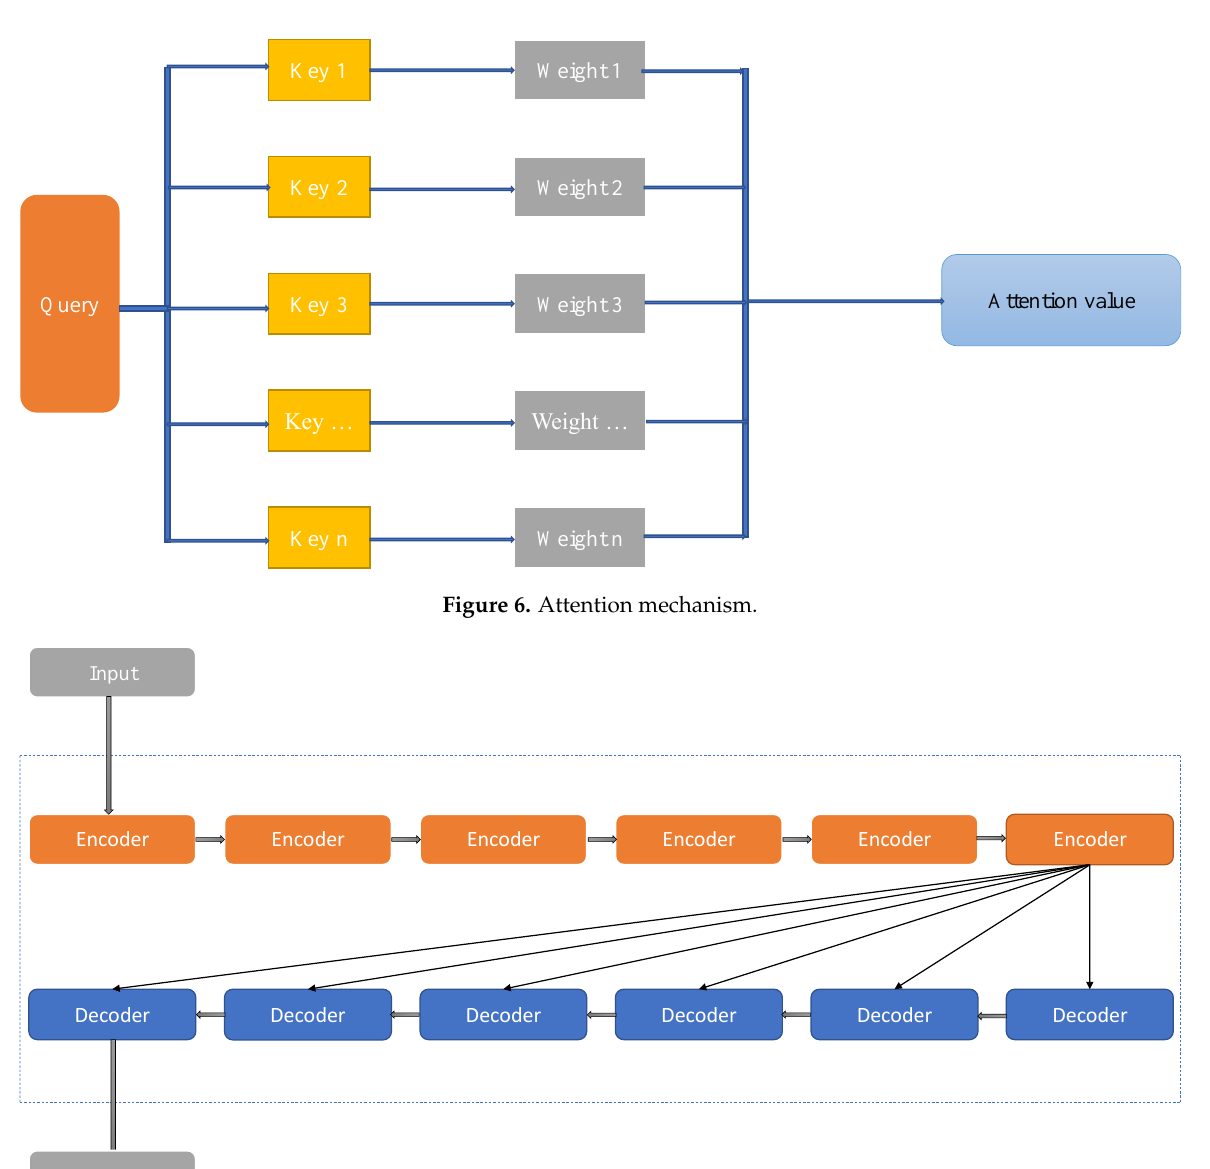
Figure 7. The architecture of the encoder and decoder in the transformer